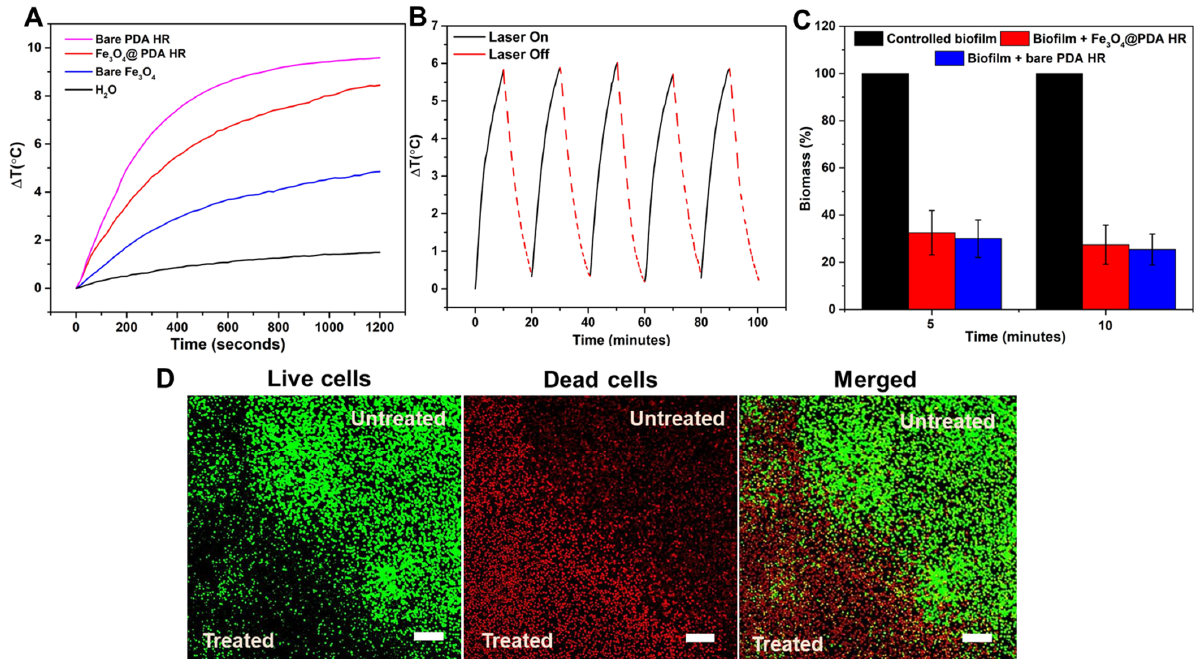
Figure 9. Photothermal conversion performance of bare Fe 3 O 4 and Fe 3 O 4 @PDA HR ( A ) and photo- stability of Fe 3 O 4 @PDA HR ( B ); Reduction of preformed biofilm biomass upon laser irradiation ( C ) and live/dead cell staining of biofilm treated with Fe 3 O 4 @PDA HR upon exposure to NIR laser (Scale bar = 10 μ m) ( D ).